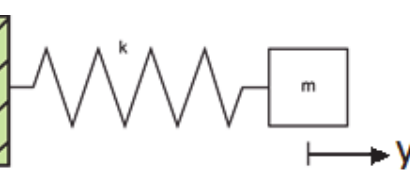
Fig. 8: simplified analogy between a mass spring system and a plate deformation under external